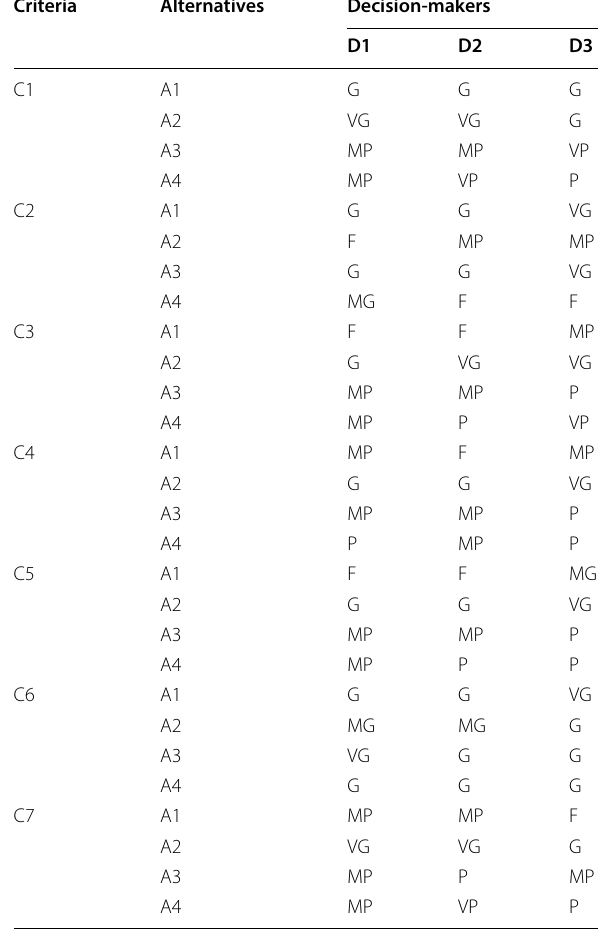
Table 8 Ratings of alternatives by decision-makers under selected criteria Criteria Alternatives